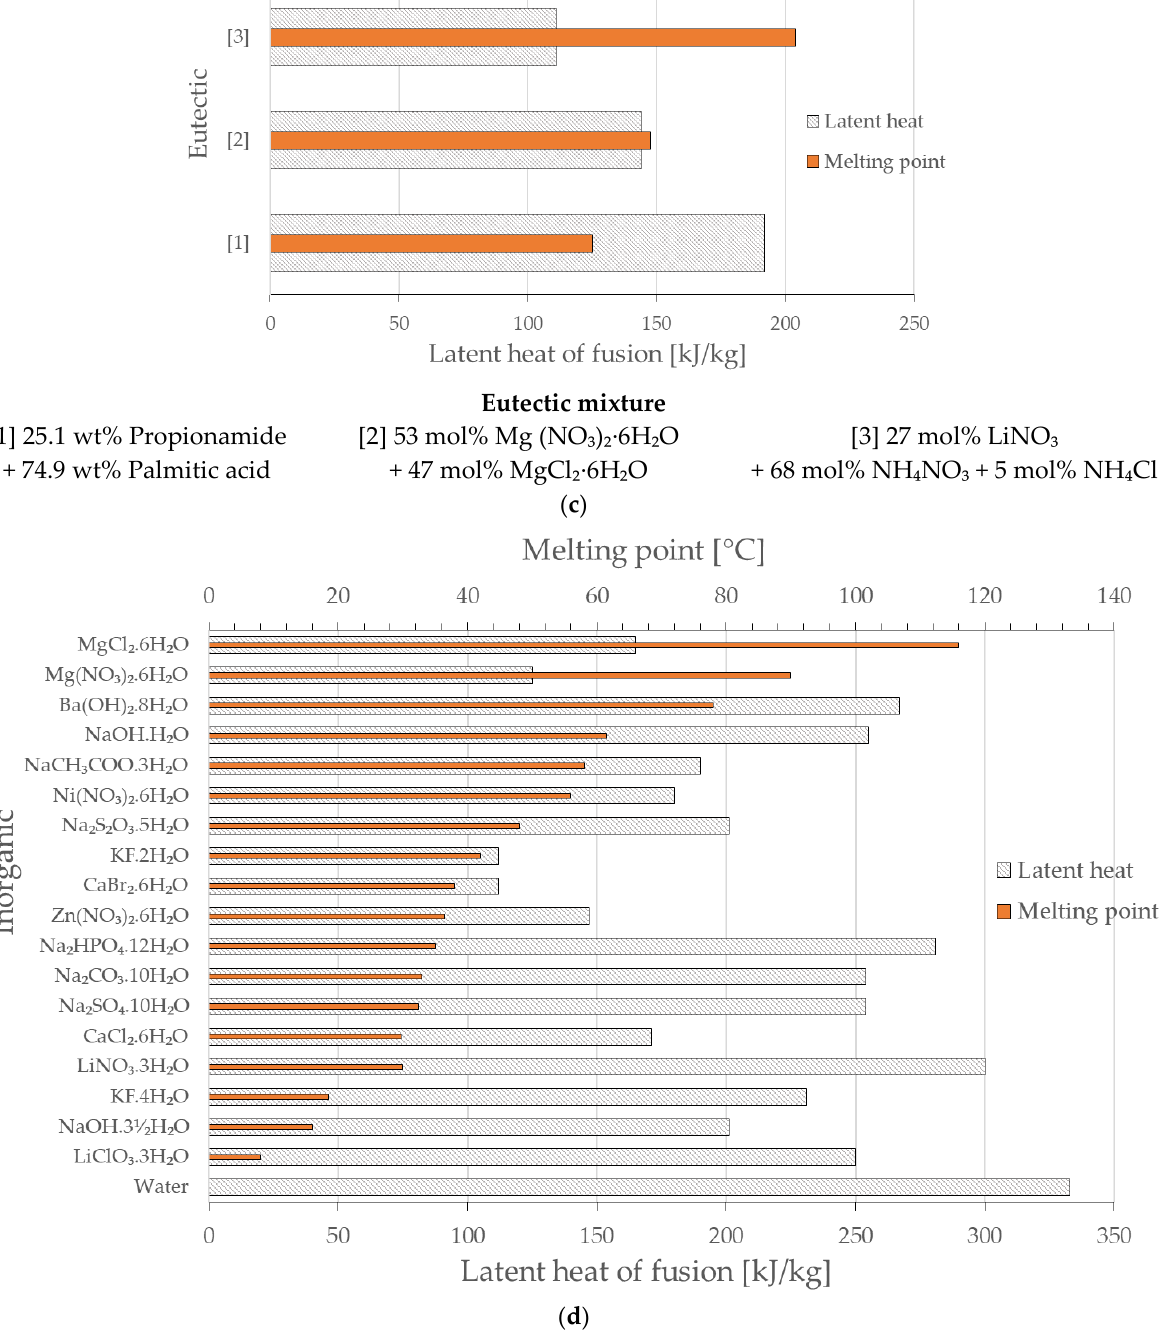
Figure 1. ( a ) Thermal properties of paraffin PCM; ( b ) thermal properties of organic PCM; ( c ) thermal properties of eutectic mixture; ( d ) thermal properties of inorganic PCM [2].